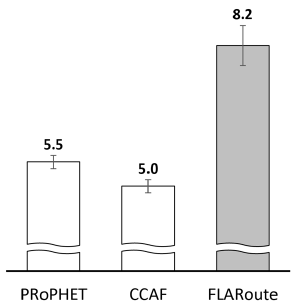
Figure 11. Throughput (in %) of the different routing techniques.